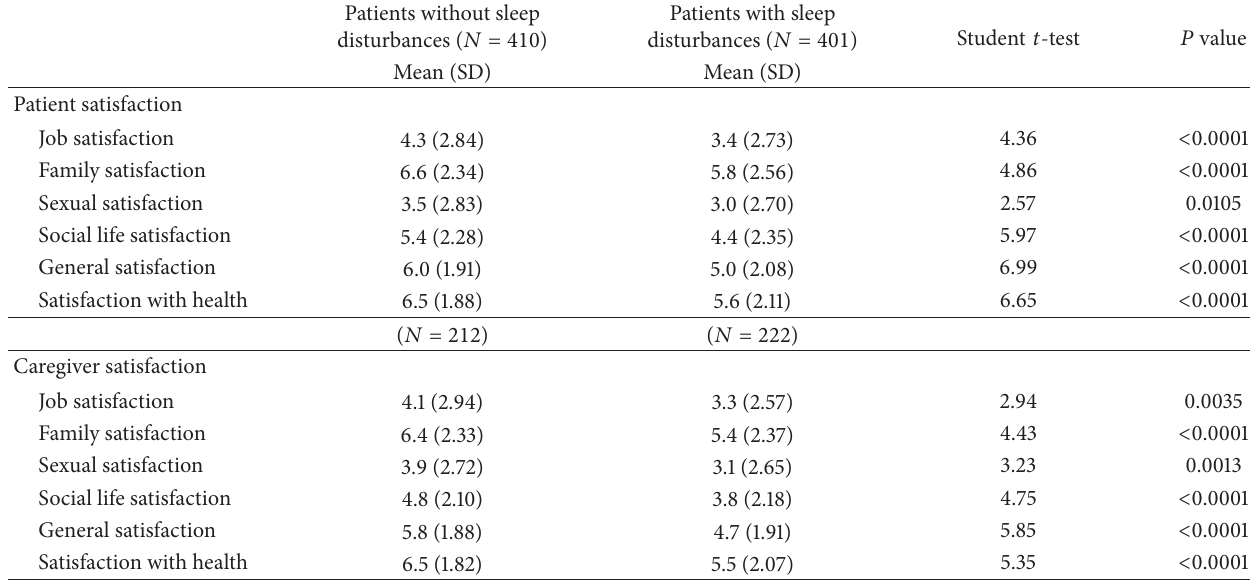
Table 1: Patients’ and caregivers’ level of satisfaction with life